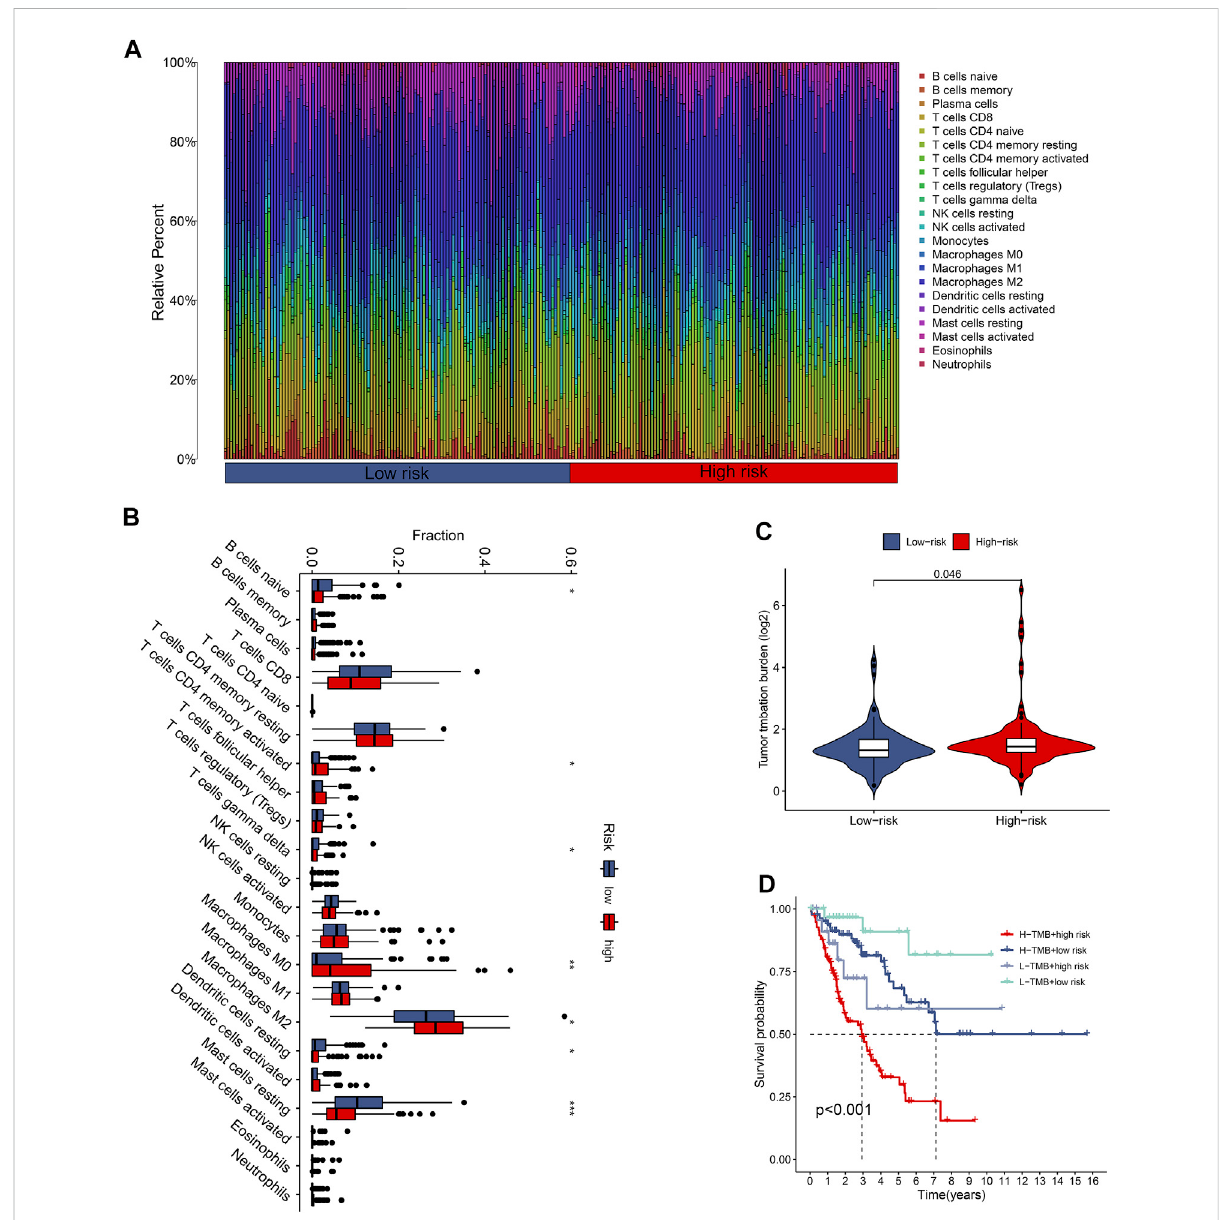
FIGURE 4 The immune landscape of the CuproScore grouping. (A) Histogram of immune cell content in high and low-risk groups. (B) Histogram of discrepancy immune in fi ltration of two groups. (C) Comparative tumor mutation burden (TMB) in the two groups. (D) Prognostic analysis of TMB in the different groups. * p < .05, ** p < .01, *** p <